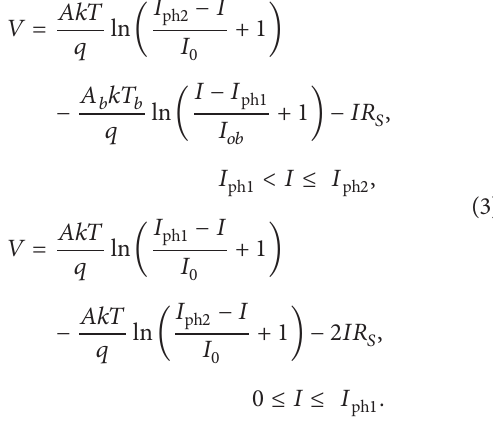
shading simulation model for PV modules is established and its reliability is verified under the standard testing condition (STC) in laboratory. The I-V and P-V characteristics of a 20- MWp grid-connected PV plant were also measured on-site to analyze the impacts of different types of partial shading. Finally some feasible solutions are proposed to avoid or reduce the shading effect during PV system operation in such